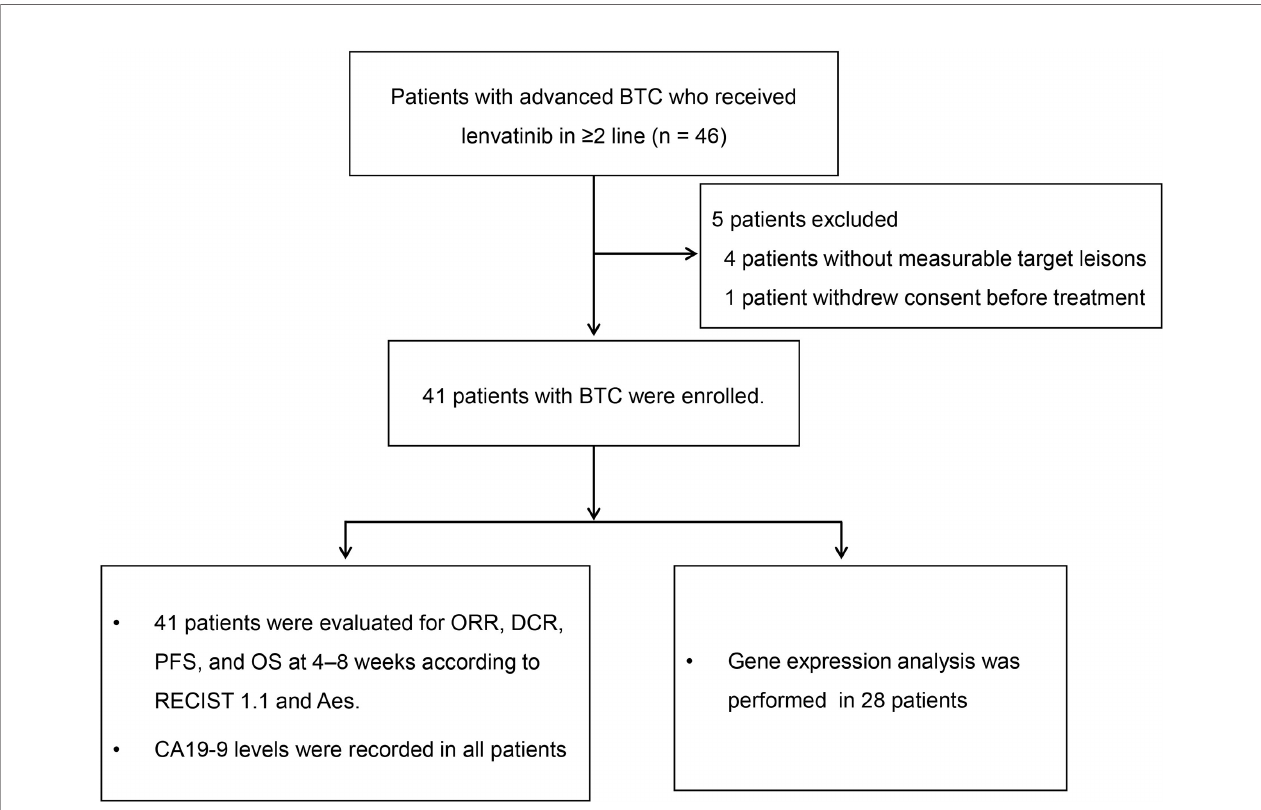
FIGURE 1 | Study fl ow diagram. BTC, biliary tract cancer; CA19-9, carbohydrate antigen 19-9; DCR, disease control rate; ORR, objective response rate; OS, overall survival; PFS, progression-free survival; RECIST 1.1, Response Evaluation Criteria in Solid Tumors version